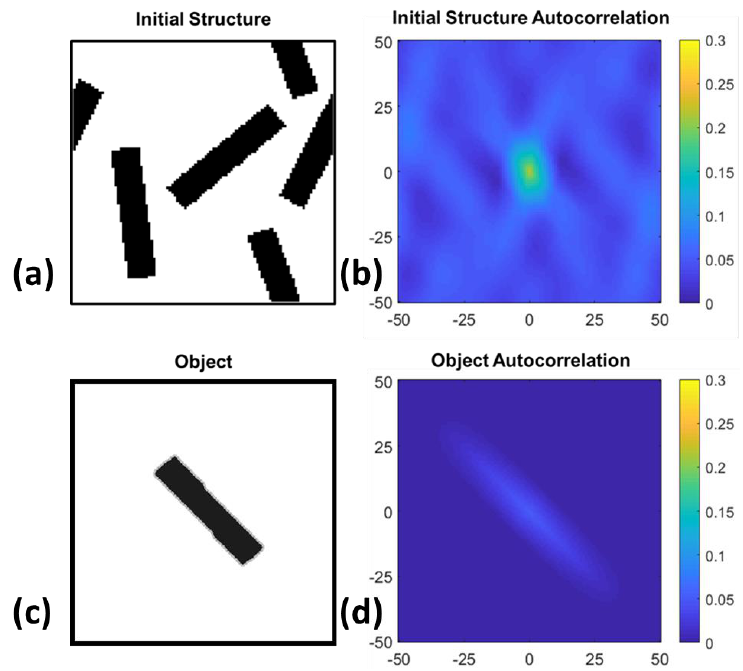
Figure 7. An example computation of the statistical cost function. ( a ) Initial structure before object placement. ( b ) Autocorrelation map of the initial structure. ( c ) Object to be placed. ( d ) Autocorrelation map of the object.